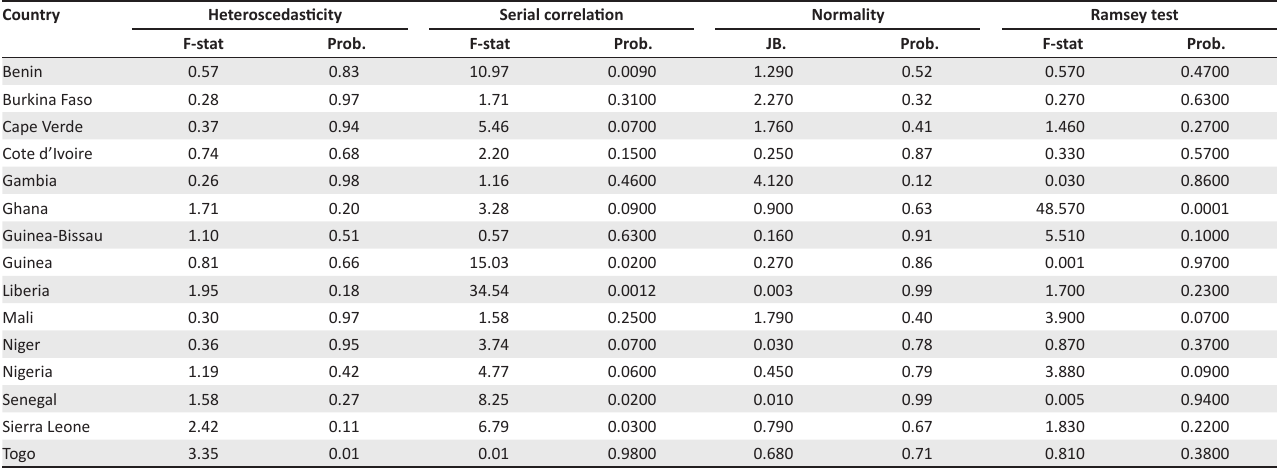
TABLE 5: Diagnostic